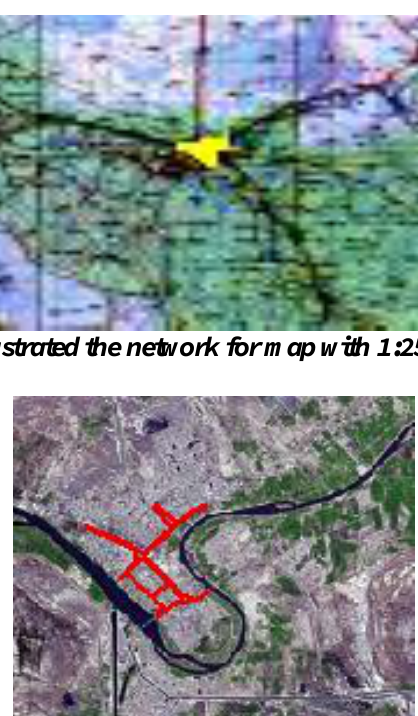
Fig.13: Illustrated the network for high resolution image with 1:250,000 scale.